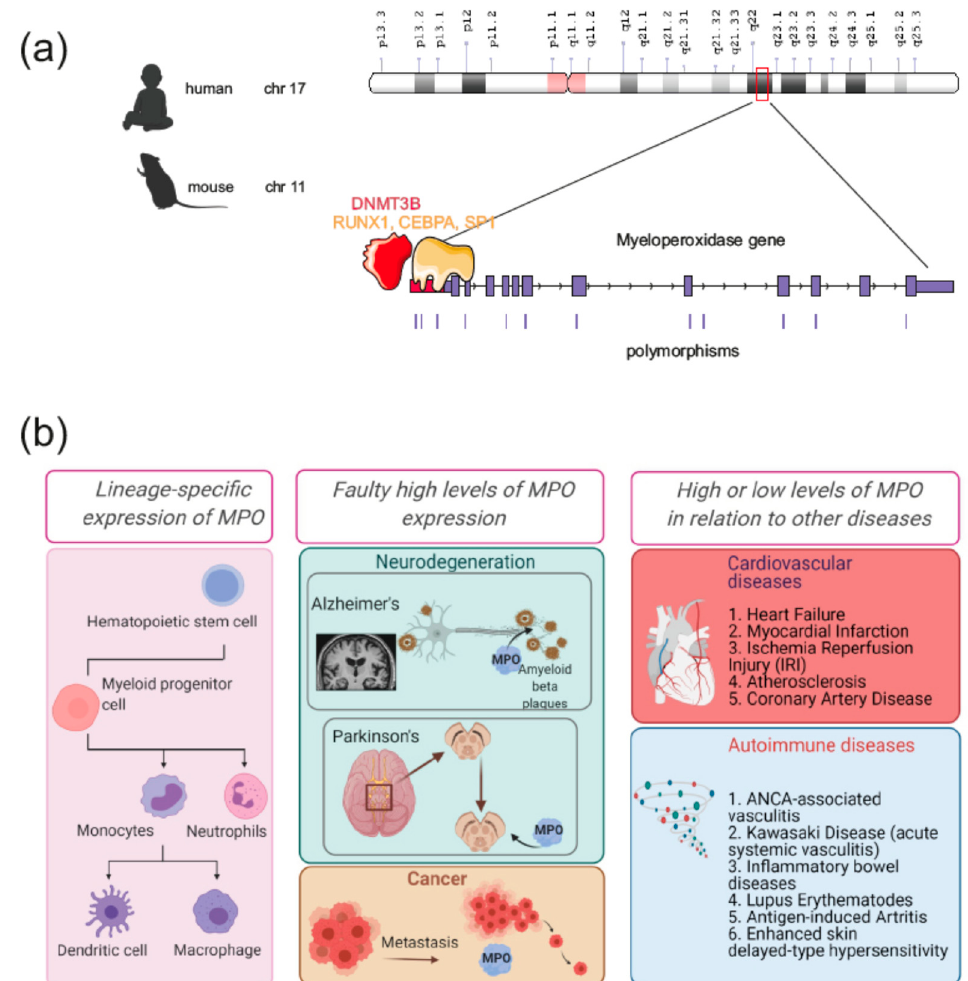
Figure 2. Myeloperoxidase gene expression regulation in health and disease. ( a ) Myeloperoxidase is located on chromosome 17 of the human genome and chromosome 11 of the mouse genome. MPO expression is tightly regulated in a lineage- specific manner by transcription factors RUNX1, CEBPA, SP1 and on the epigenetic level by variations in DNA and histone methylation patterns. ( b ) MPO expression is tightly regulated in a lineage-specific manner. De-regulation of MPO expression is associated with cancer and neurodegenerative diseases, whereas cardiovascular diseases are usually associated with increased MPO levels, and autoimmune diseases are associated with both too high and too low levels of MPO.